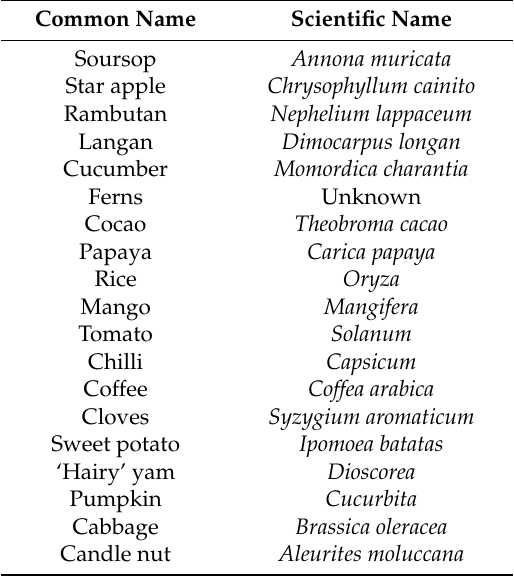
Table A1. Food crops grown in the study